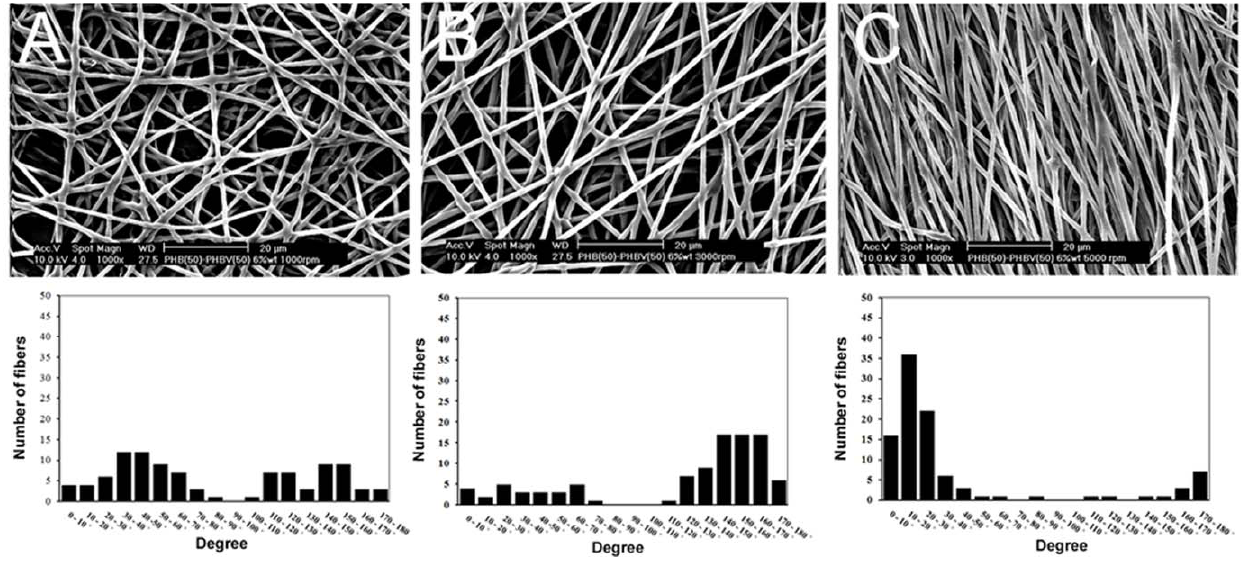
Figure 4. SEM images and histograms illustrating the orientation of PHB(50)/PHBV(50) nanofibrous mats. Nanofibers collected with speed of (A) 1000 rpm, (B) 3000 rpm, (C) 5000 rpm. The voltage, flow rate and collecting conditions were fixed at 16 kV, 1.5 ml/h and 15 cm, respectively. Scale bars represent 20 m m for SEM images.